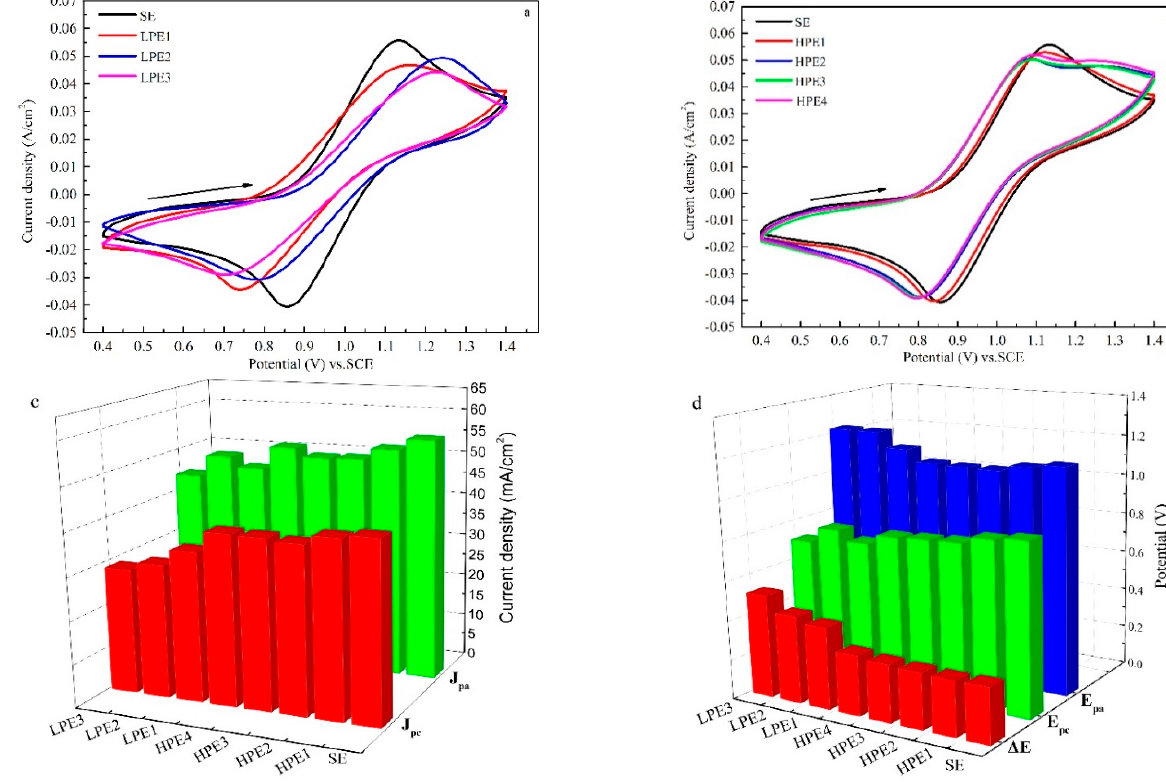
Figure 4. CV curves of ( a ) low purity electrolytes and ( b ) high purity electrolytes, ( c ) the peak current, and ( d ) the peak potential of electrolytes prepared with different grades of V 2 O 5 material.